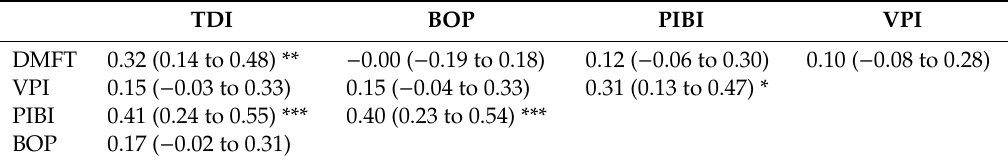
Table 3. Results from correlation analyses between the oral health parameters. TDI BOP